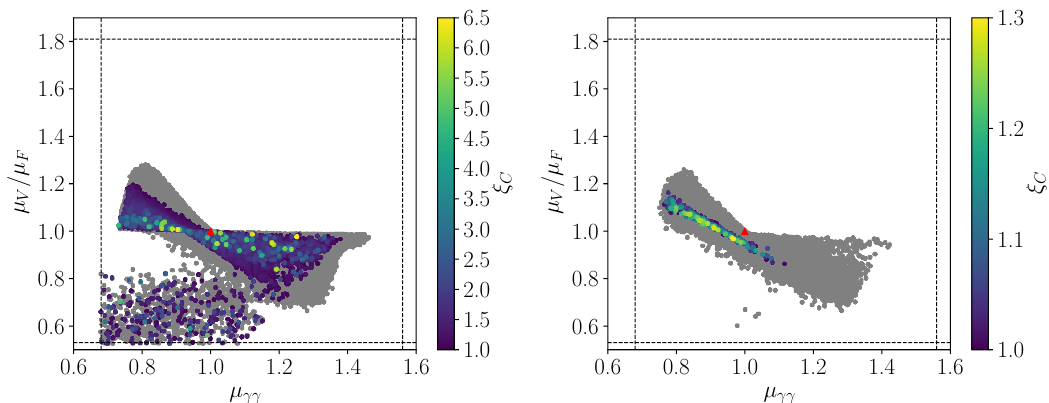
Figure 15 . Type II, H 1 = h : (cid:22) V =(cid:22) F versus (cid:22) (cid:13)(cid:13) . Grey: all points passing the applied constraints, colour: all points with additionally (cid:24) c 1; left: all 2HDM points, right: only C2HDM points. The (cid:21) red triangle marks the SM result.